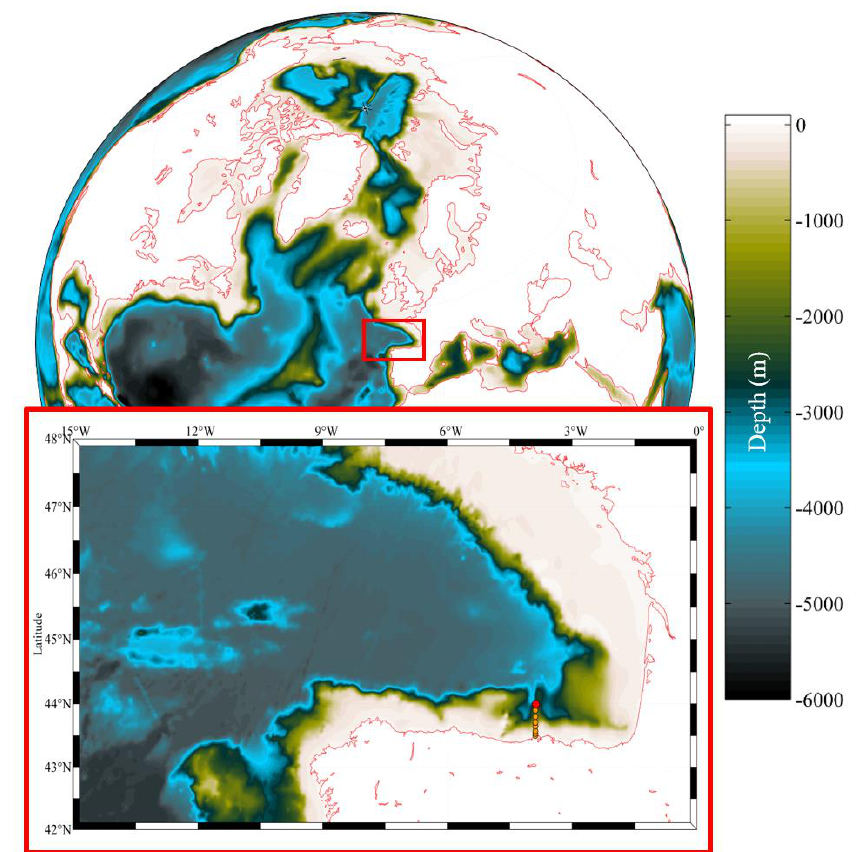
Figure 1. Upper: Map of the North Atlantic Ocean showing the location of the mid-latitudes of the Eastern North Atlantic (ml-ENA, red box in the map). Lower: Zoom to ml-ENA where Santander Atlantic-Time-Series (SATS) oceanographic station is located (red dot in the map). The location of the remaining stations of the Santander standard section are also shown (orange dots).